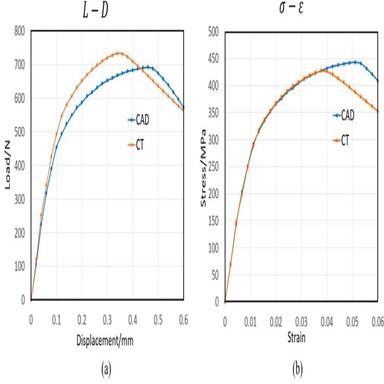
FEA results of single CT reconstructed strut and CAD strut: (a) Load-displacement curves; (b) stress–strain curves.